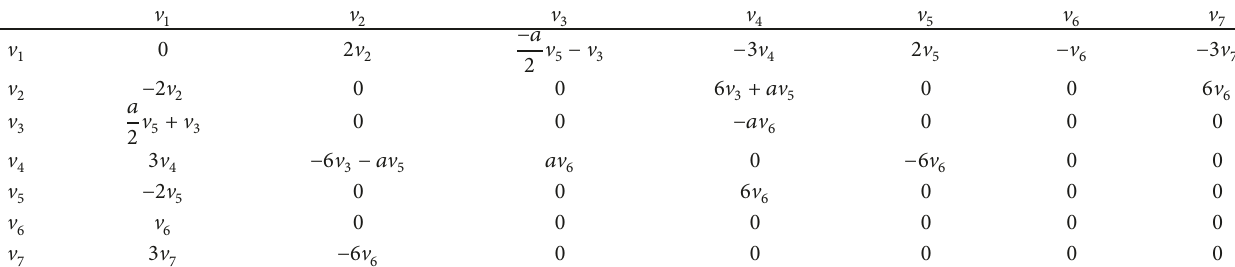
Table 3: Approximate commutators of approximate symmetry algebra of (1) ( 𝛼 = −𝛽 , 𝑎 = 3𝛼 ).